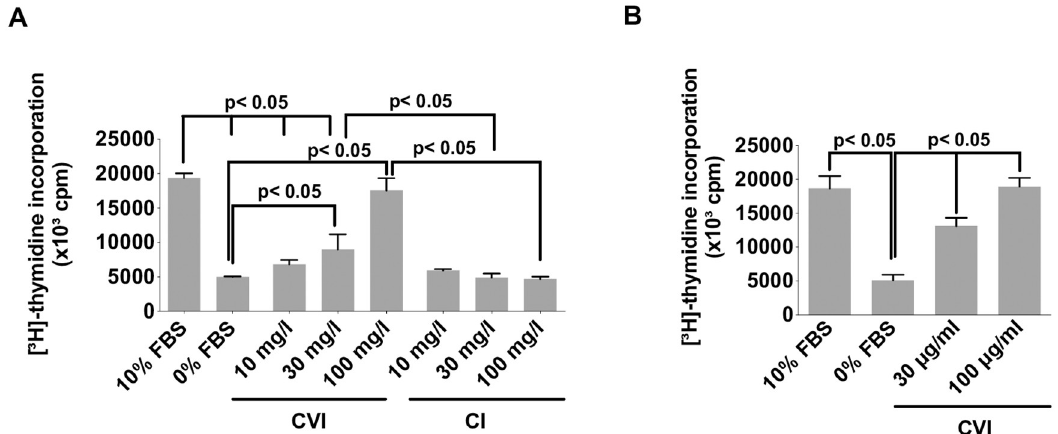
Fig 2. Soluble CVI is sufficient to increase HSC proliferation. ( A ) Serum-starved primary HSCs were treated with increasing concentrations of CI, CVI or 10% FBS as a positive control for 24 h. Proliferation was determined by [ 3 H]-thymidine incorporation. Shown is the Mean ± SD from three independent experiments( B ) CFSCs were incubated with indicated concentrations CVI for 24 h and proliferation was assessed by [ 3 H]-thymidine incorporation. Cultures receiving equivalent amounts of the CVI solvent acetic acid (HAc) alone served as negative controls. Mean values ± SD (n = 3). Differences were calculated by one-way ANOVA analysis and Tukey’s multiple comparisons test. Differences p < 0.05 were considered